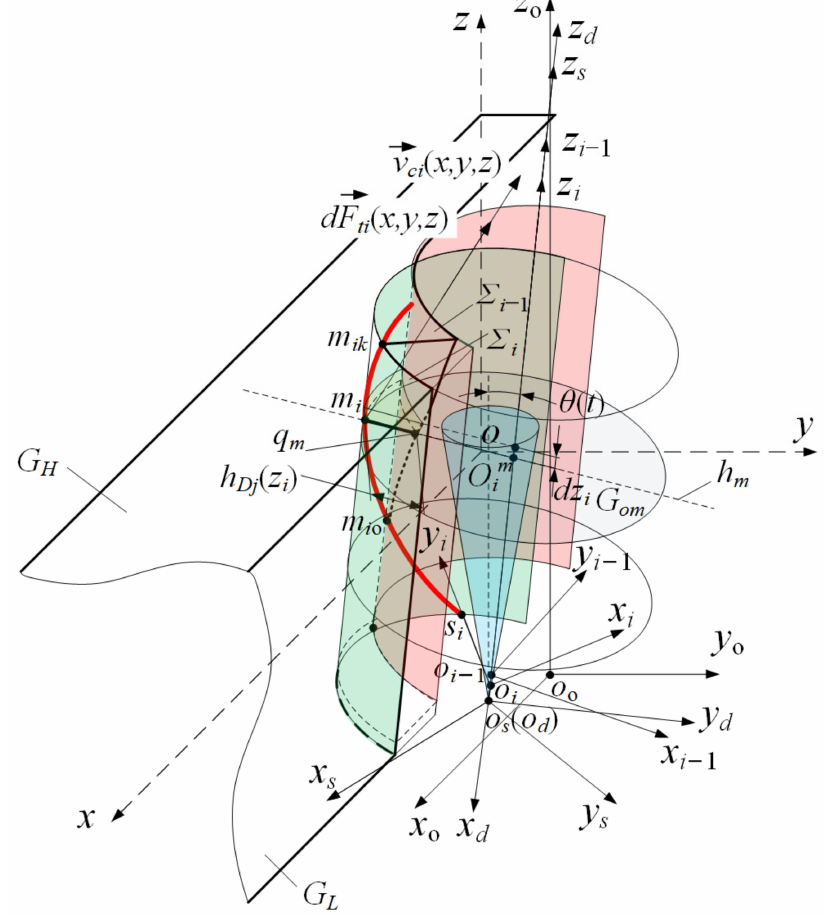
Figure 4. Instantaneous cutting speed and main cutting force of the cutter tooth cutting